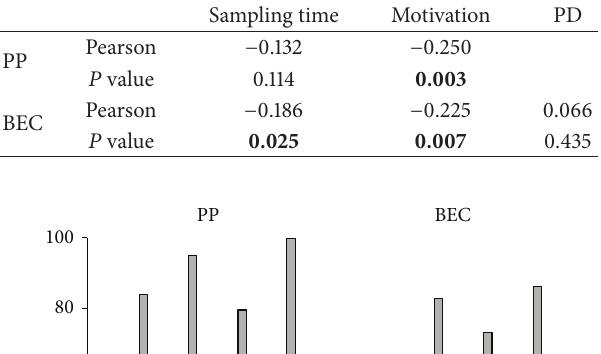
Table 4: Evaluation of correlations.